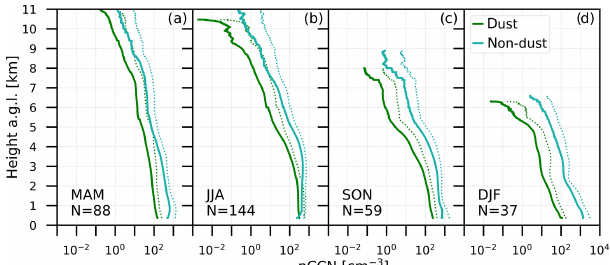
Figure 15. Same as Fig. 12 except for seasonal mean dust and non- dust CCN concentrations (for 0.2% supersaturation) in (a) spring, (b) summer, (c) autumn, and (d) winter. The dotted lines again show the (mean + SD) values. Considered nighttime observations N are given as